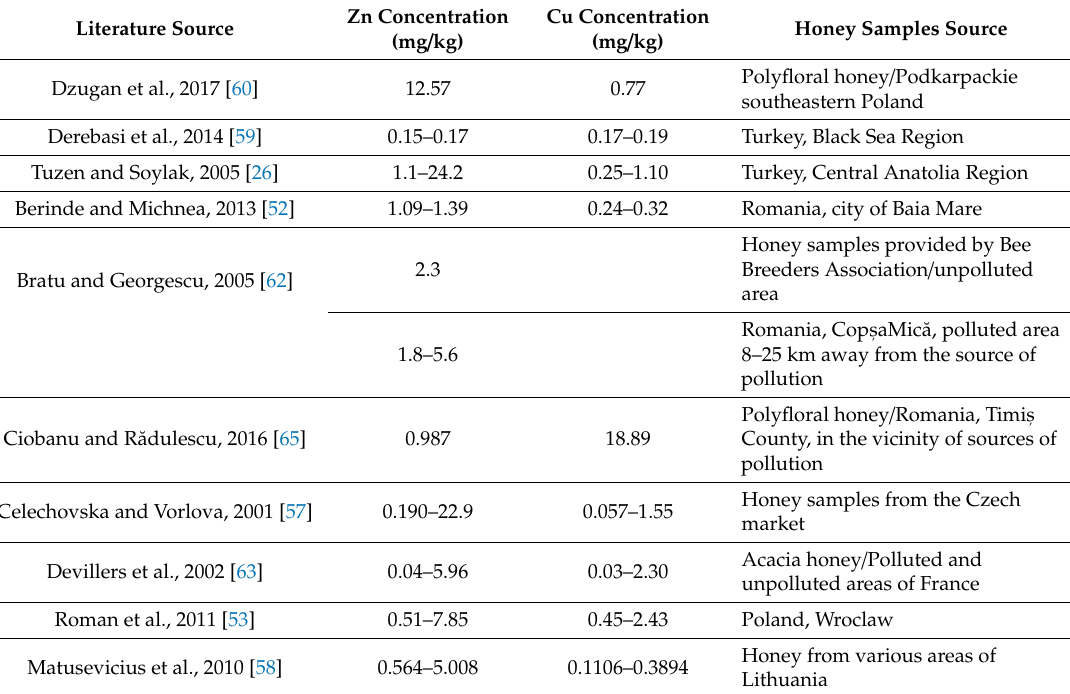
Table 7. Comparative results on honey contamination with Zn and Cu in di ff erent research